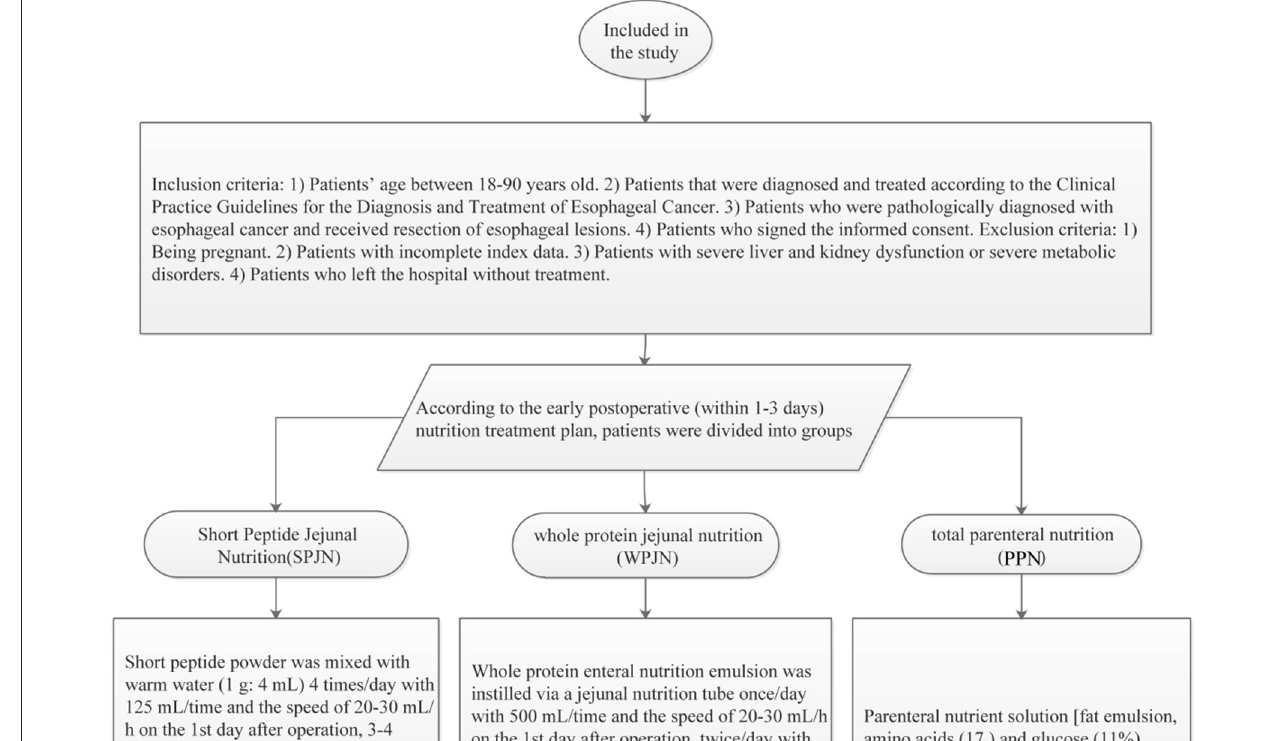
Frontiers in Nutrition |